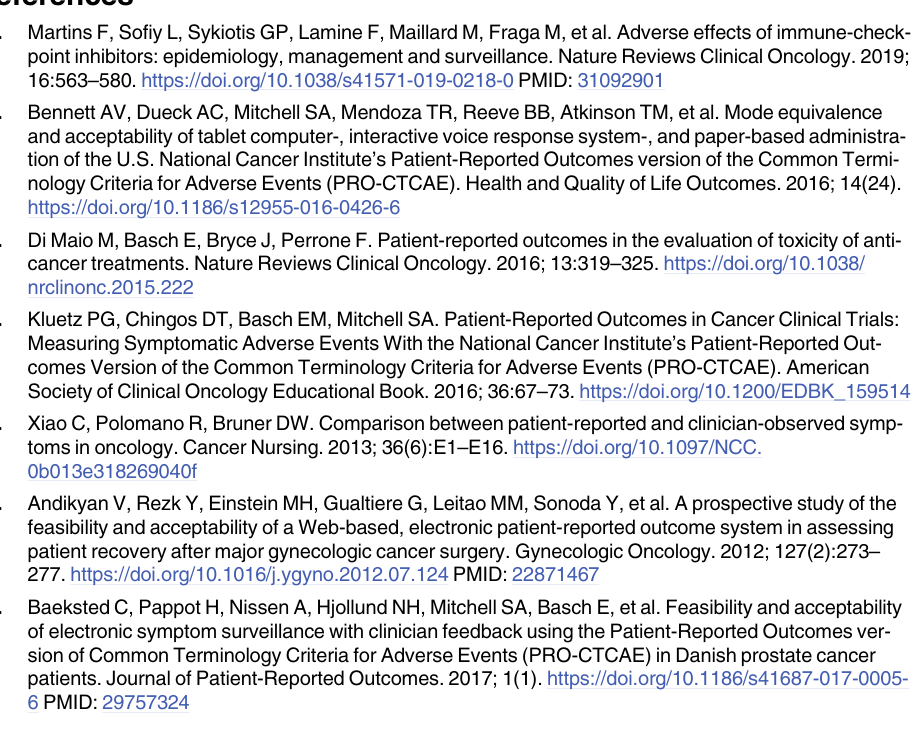
S3 Table. Questions for smartphone